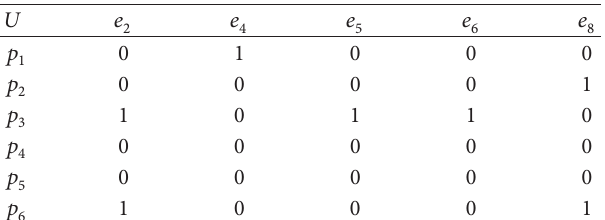
Table 4: Tabular representation of the soft set T 4 = 𝐿( S ;0.9)